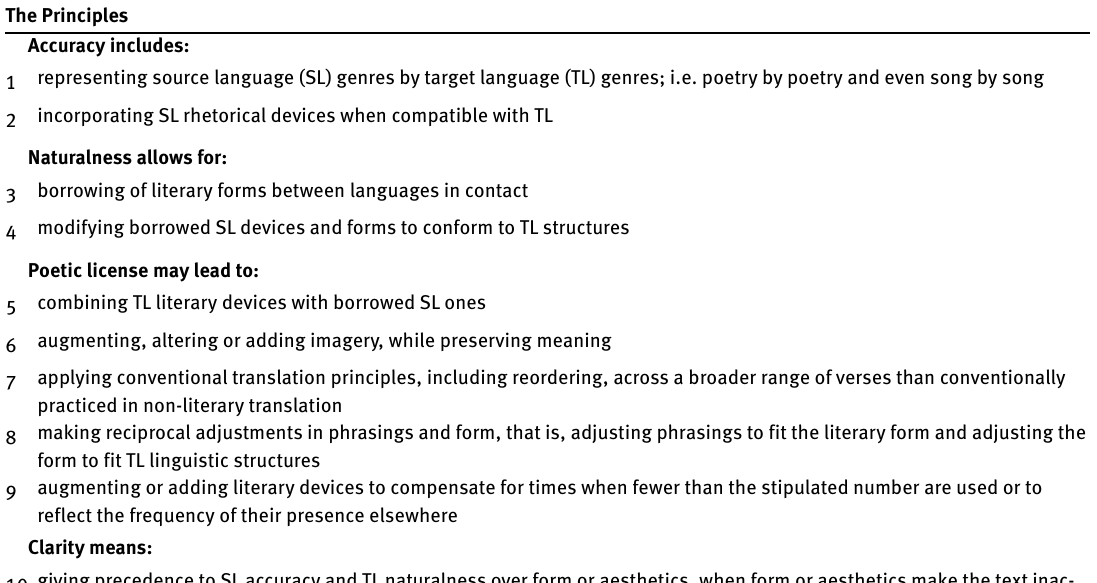
Table 1. Ten extended principles for literary